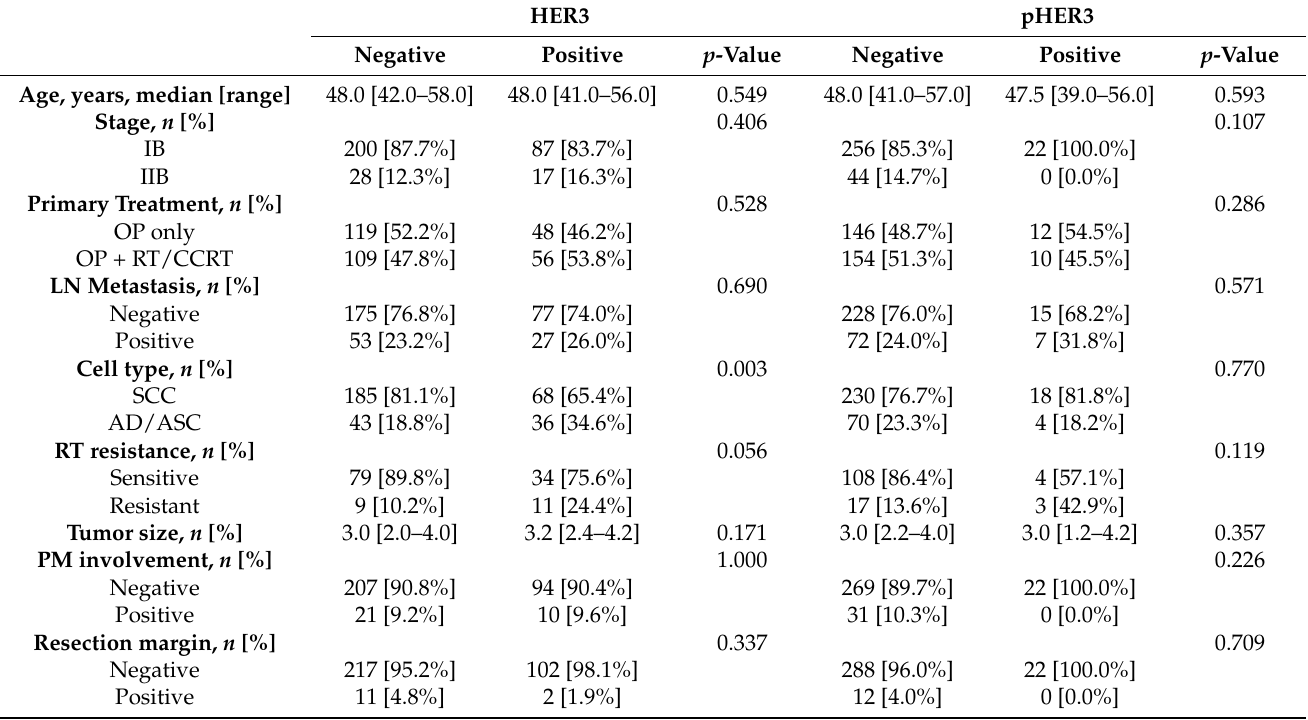
Table 1. The 336 cervical cancer patients’ clinicopathological characteristics.